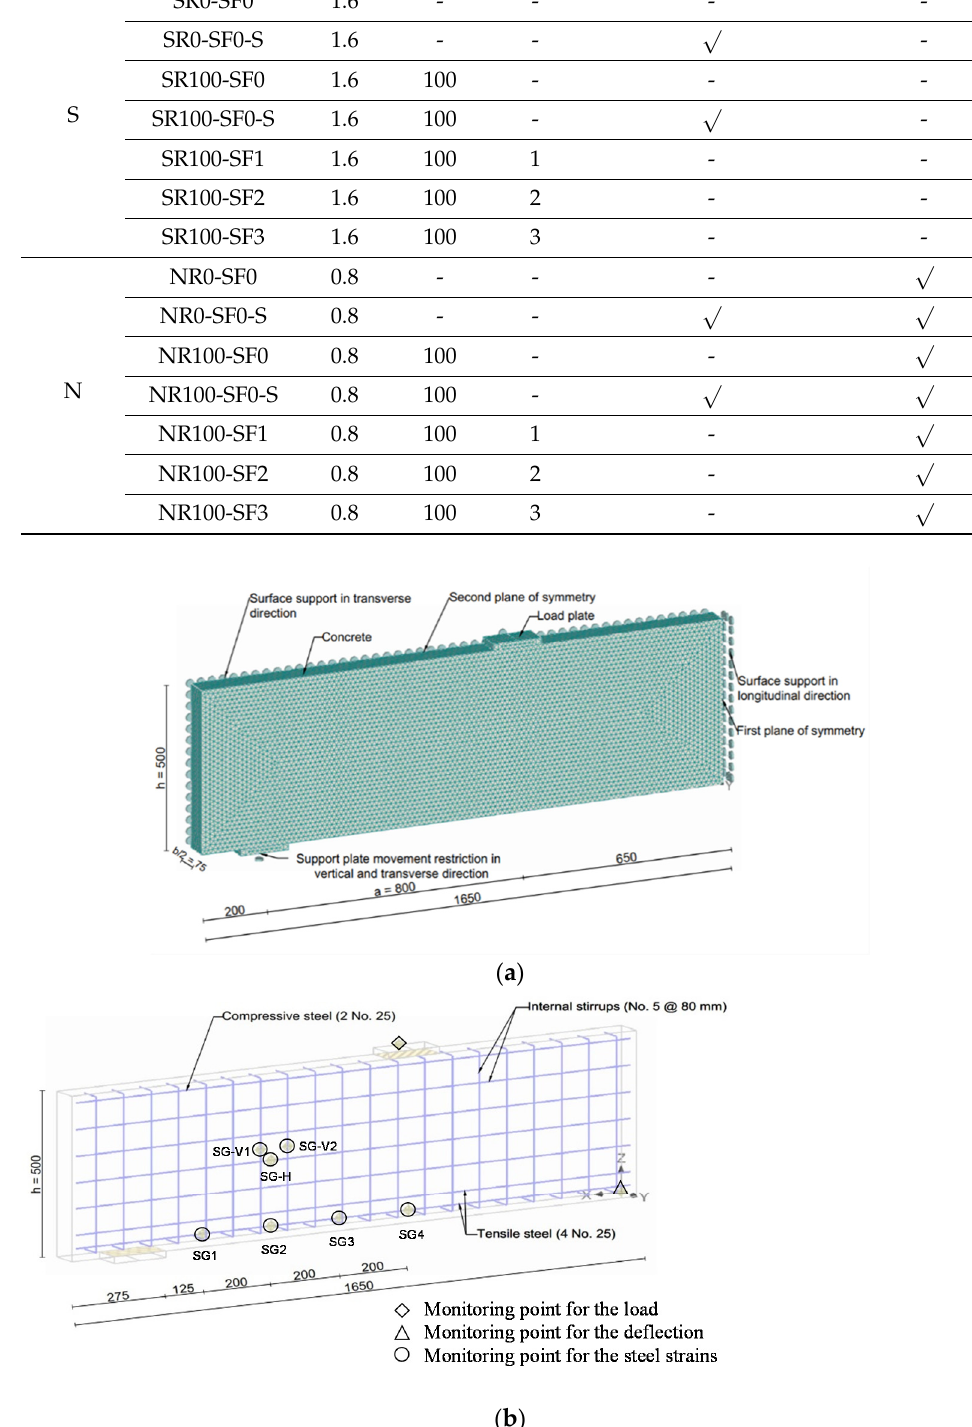
Figure 5. A typical deep beam model of group S (dimensions are in mm): ( a ) beam geometry configuration and boundary conditions; ( b ) reinforcement details and monitoring points.